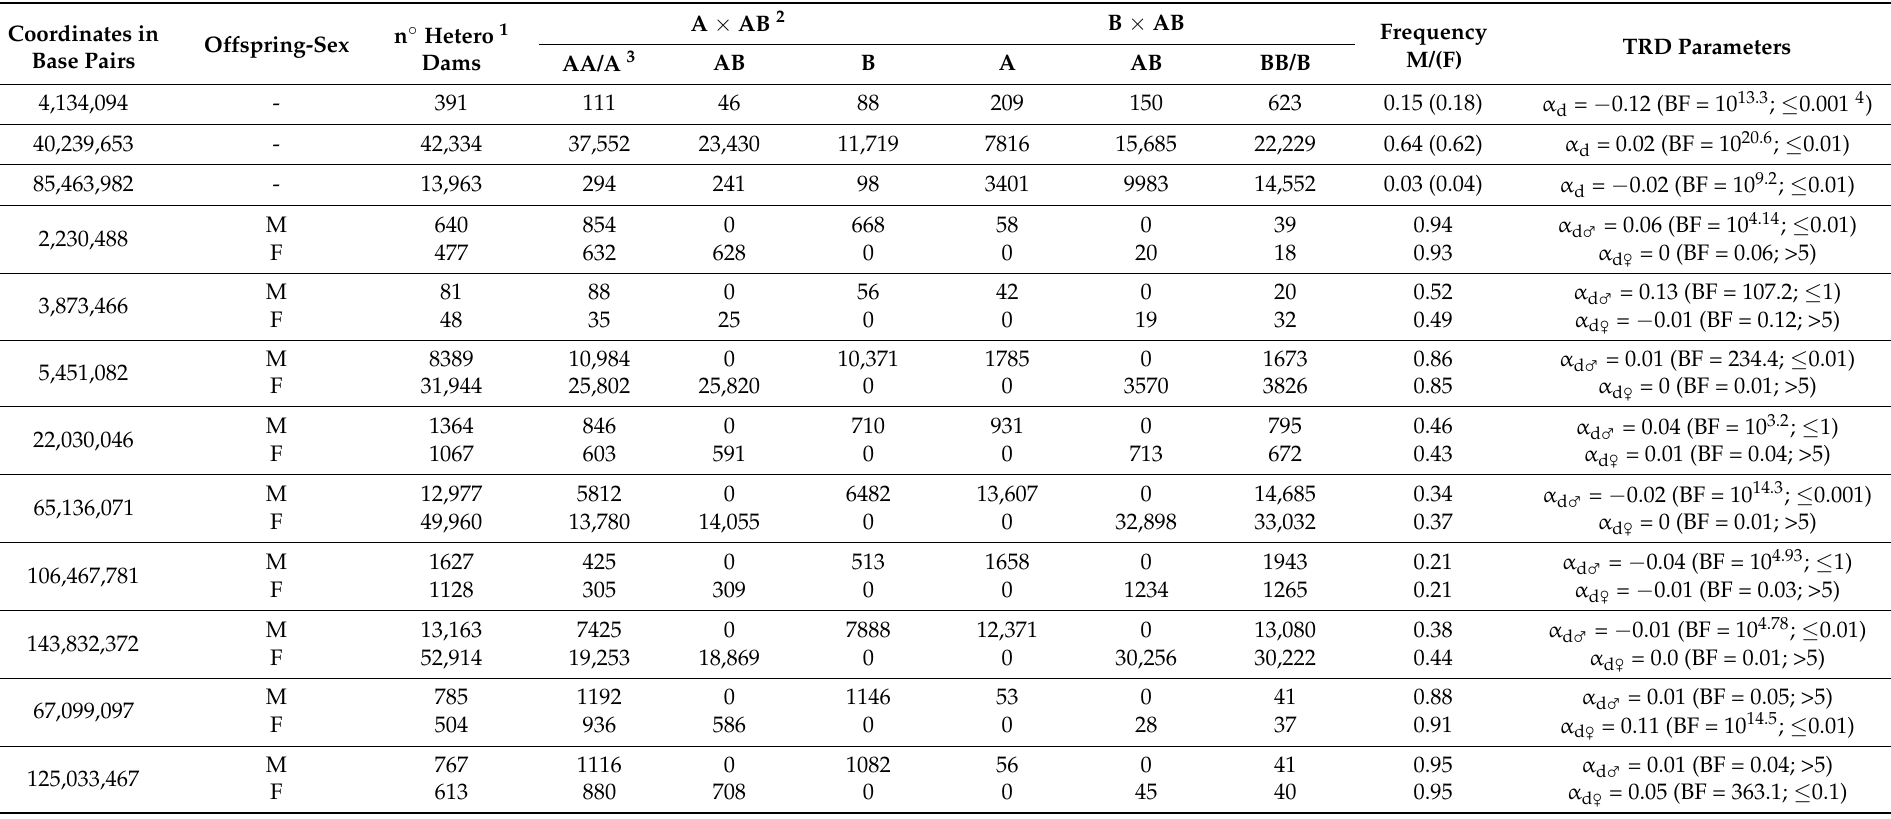
Table 2. Significant dam-TRD, male- and female-dam-TRD among heterosomal SNPs in Holstein